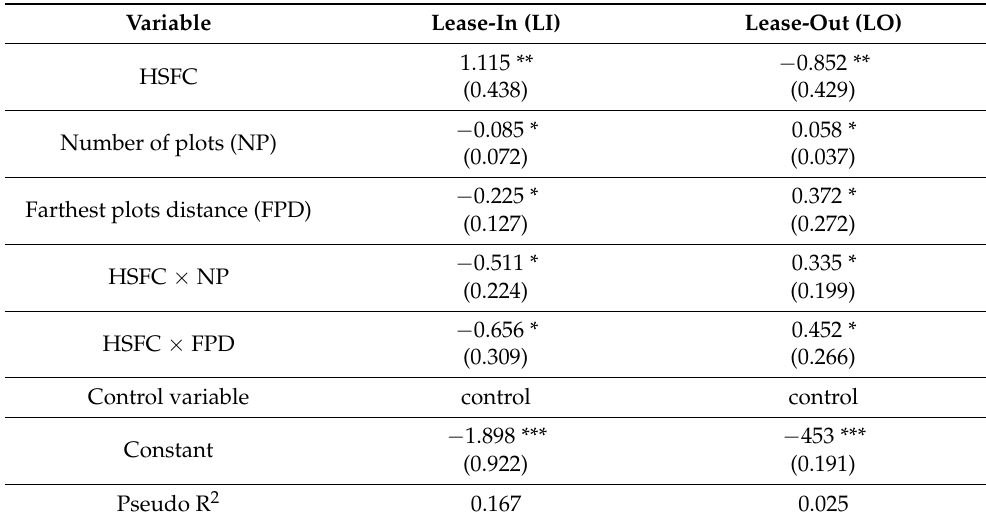
Table 4. Result of moderating effect